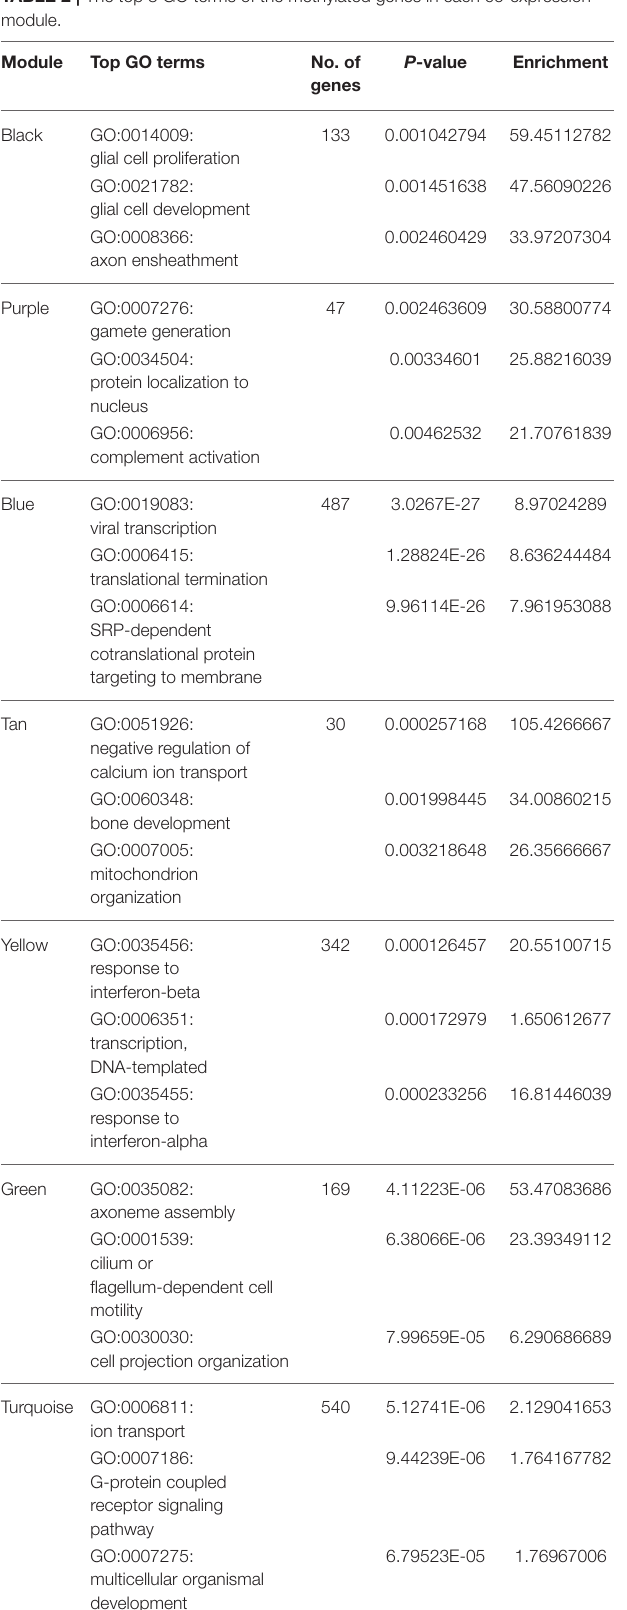
TABLE 3 | The hub genes and the lncRNAs of the 7